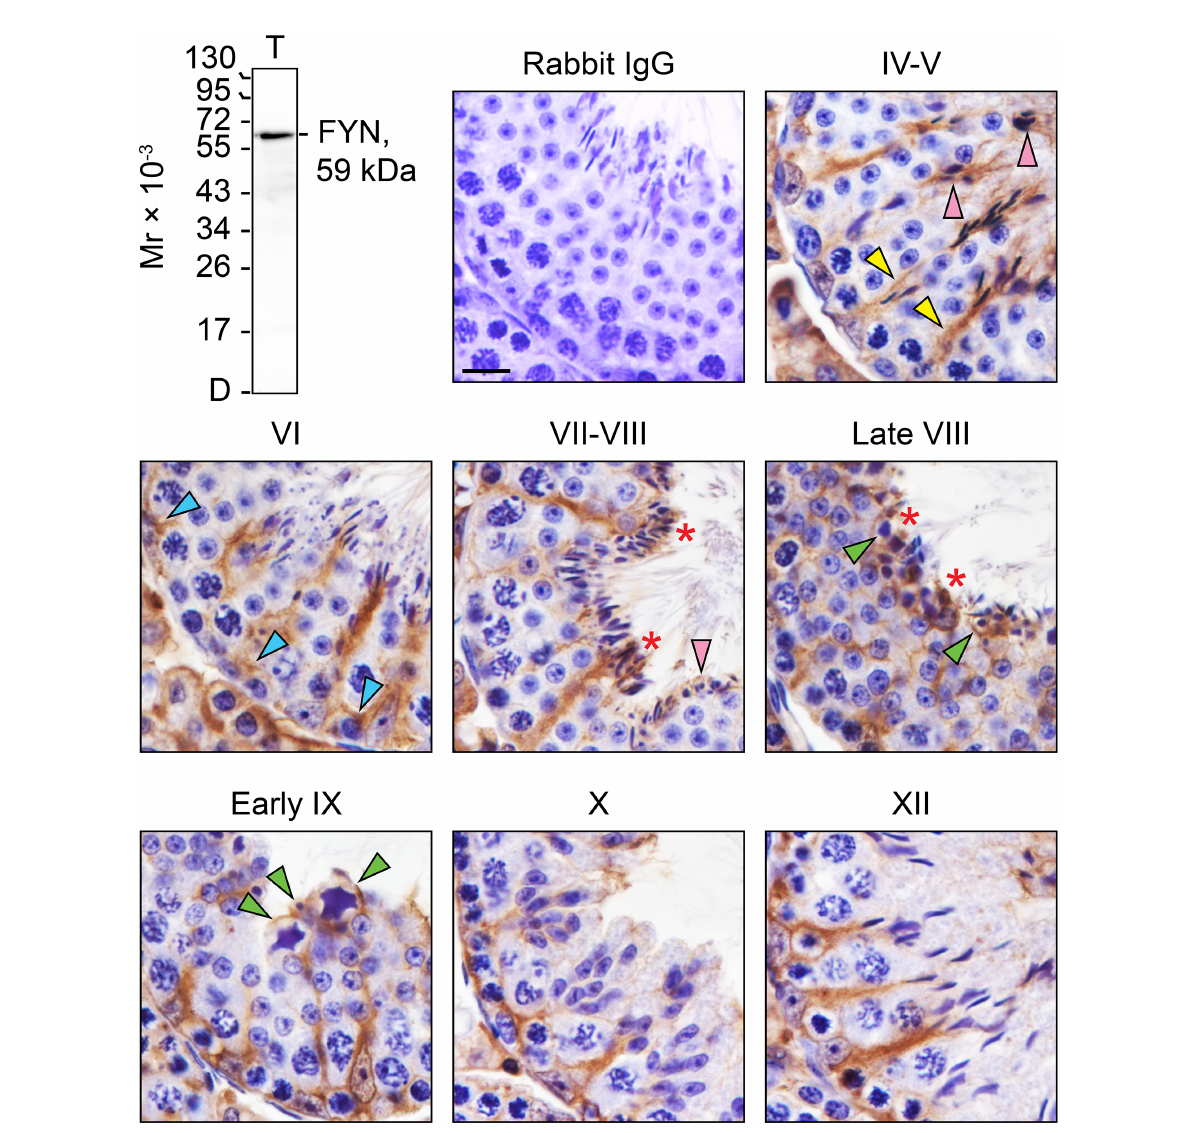
FIGURE 1 FYN expression and distribution patterns in adult mouse testes. Testes from 8-week-old mice were fi xed in Bouin ’ s solution, paraf fi n embedded, and tissue sections were cut at 5 µm and immunostained using a rabbit anti-FYN polyclonal antibody (see Table 1). Seminiferous tubules from various stages of the seminiferous epithelial cycle (denoted by Roman numerals IV-XII) were displayed. FYN was found at the Sertoli cell stalk (yellow arrowheads), the elongating and elongated spermatids (pink arrowheads), and the blood-testis barrier (blue arrowheads) as a brown precipitate utilizing 3,3 ’ -diaminobenzidine (DAB) enzymatic detection. FYN was also detected at the luminal edge (red asterisks), and around residual bodies/phagosomes (green arrowheads). No immunoreactive signal was present in the negative control when the primary antibody was replaced with rabbit IgG. Scale bar, 10 m m. This antibody used for IHC was speci fi c for FYN when assessed by immunoblotting using lysate (30 µg of total protein) from mouse testes (T). Mr, molecular weight; D, dye